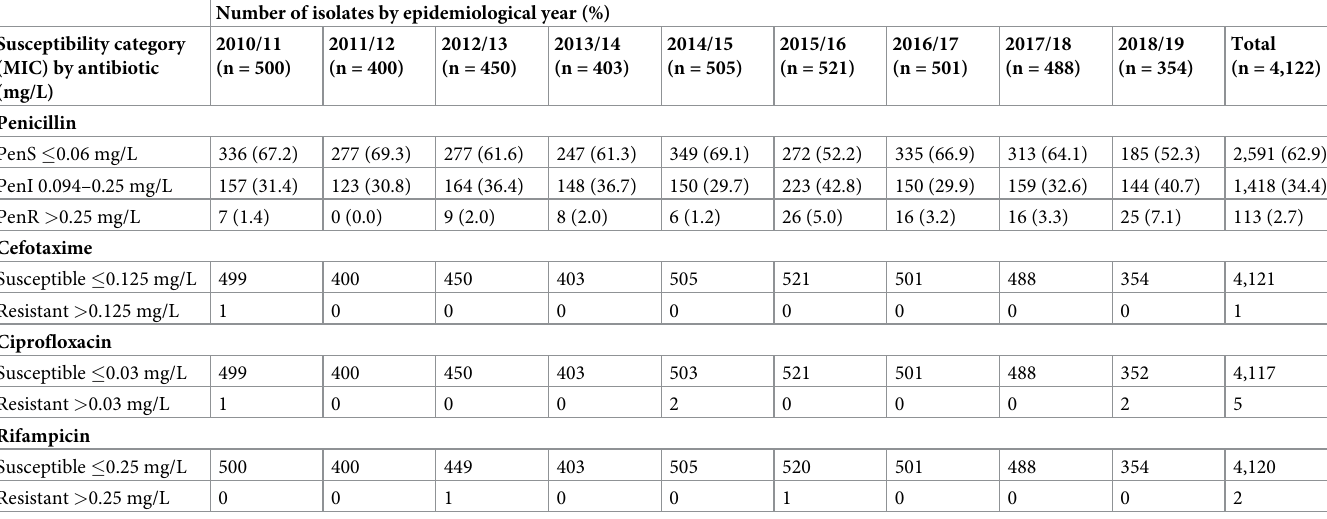
PenS = Penicillin susceptible, standard exposure; PenI = Penicillin-susceptible, increased exposure; PenR = Penicillin-resistant according to EUCAST guidelines. The annual percentage of PenS, I and R isolates is also